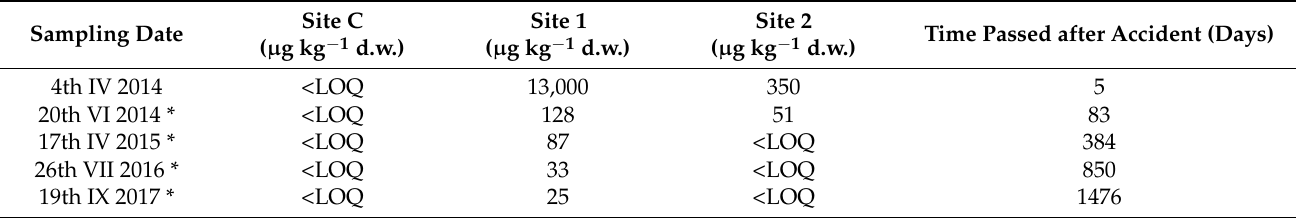
Table 1. Chlorpyrifos content in the sediments analysed in the samples from Sites C (control = unaffected, Transect 1), 1 (affected, Transect 1) and 2 (affected, Transect 2) during the sampling period 2014–2017. The asterisks